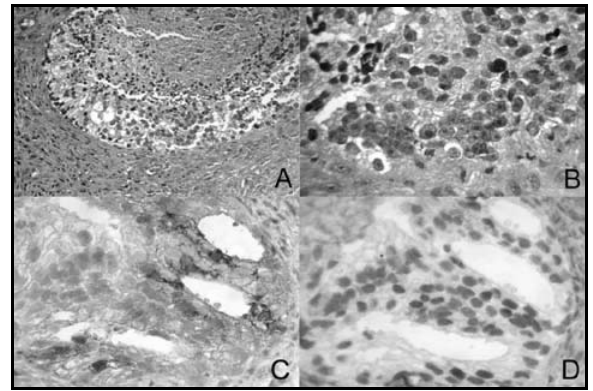
Figura 1 – Adenocarcinoma com formações glandulares revestidas por células de citoplasma claro, com área de necrose central (H&E: A = 160x; B = 400x). A lesão foi positiva para PSA (C = 400x) e CDX-2 (D =